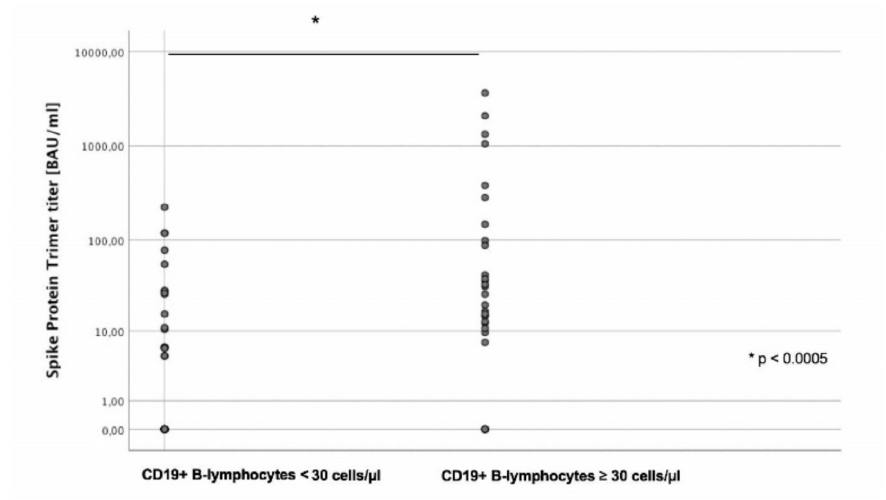
Figure 3. Median numbers of anti-SARS-CoV-2 antibody titers (spike-protein trimer) (Y axis, loga- rithmic) depending on CD19+ B lymphocyte count (X axis). Antibody titers were significantly lower in patients with low compared to high CD19+ B lymphocyte count (<30 vs. ≥ 30 cells/ µ